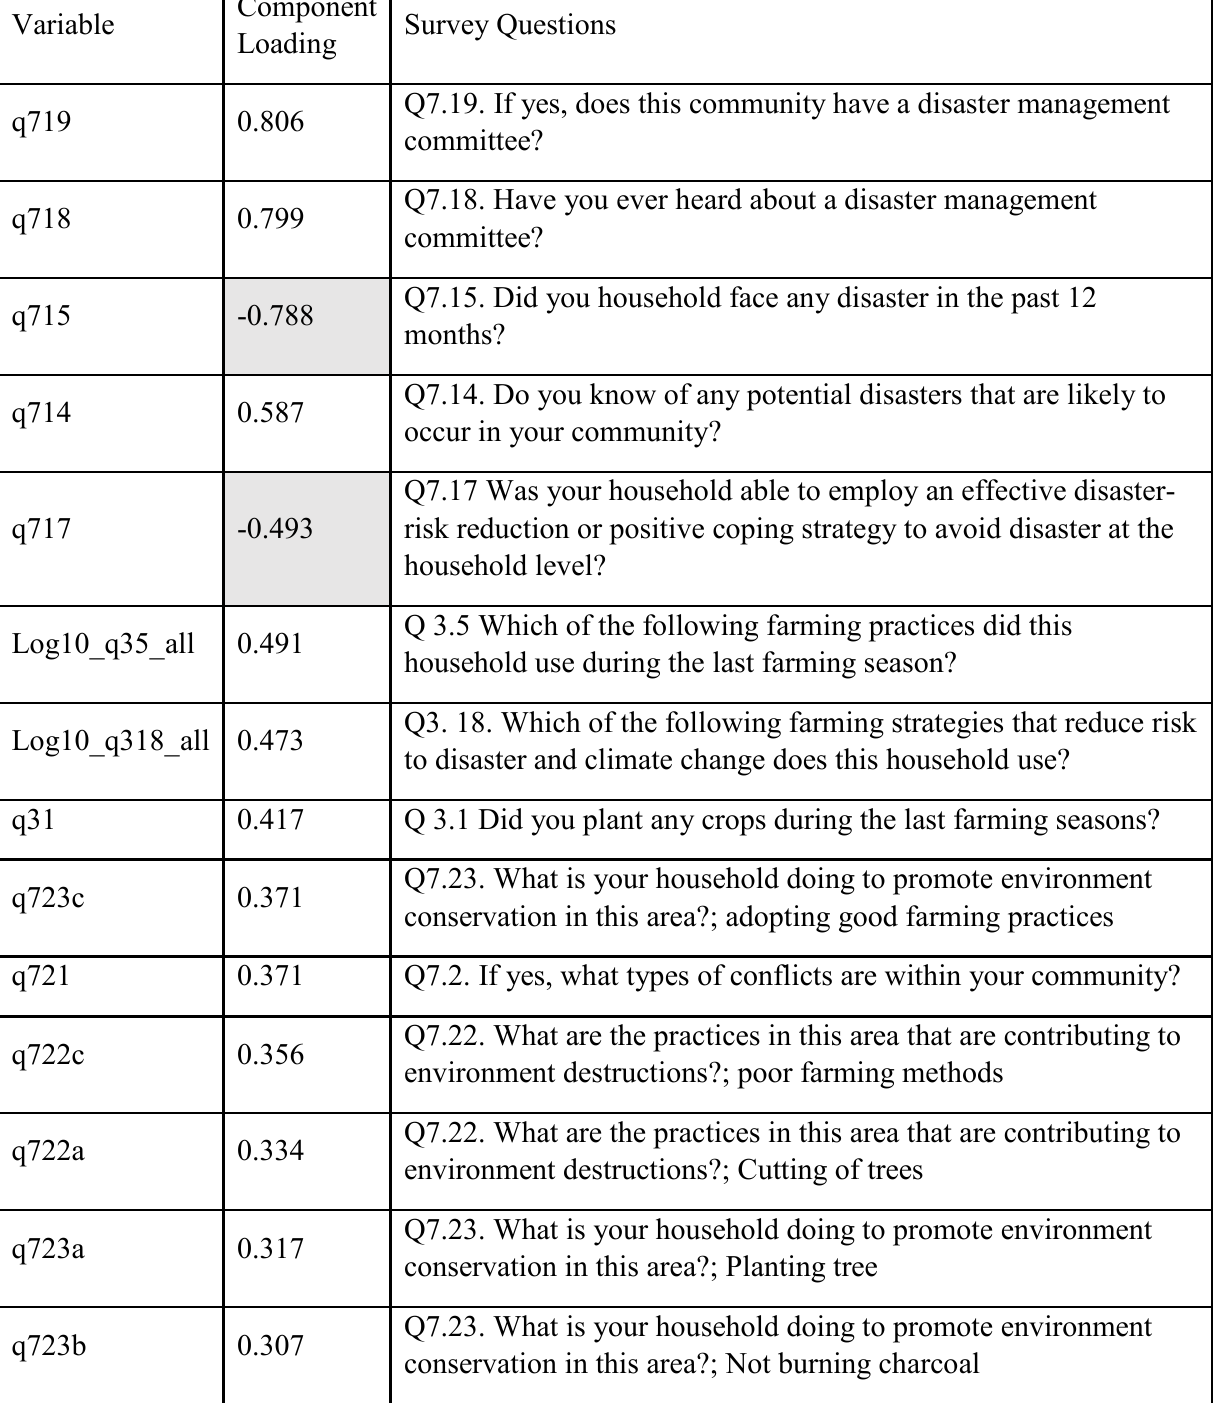
Table 1.24: Variables defining Adaptive Resilience